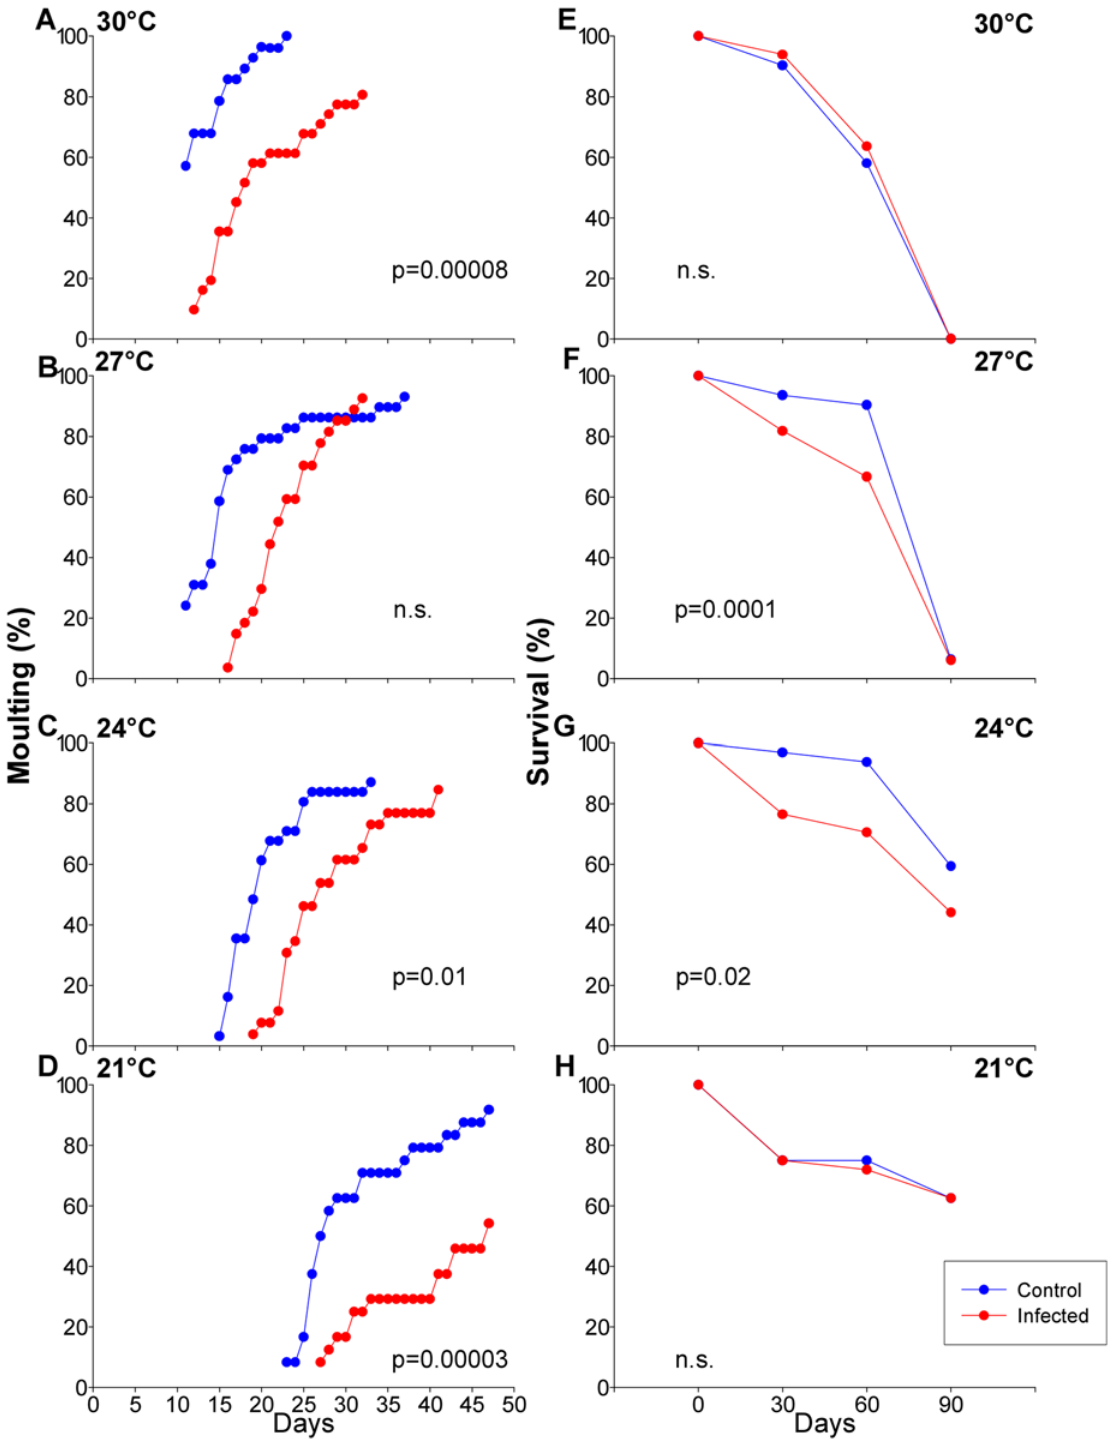
Fig 1. Effects of Trypanosoma cruzi infection on second instar Rhodnius prolixus nymphs over four temperatures. Insects were fed a blood meal at day 0 and were offered no further food. (A-D) time required to moult from second to third instar. (E-H) survival at 30, 60 and 90 days post-blood meal. P values indicated in each graph represent statistical significances of comparisons of infected versus uninfected control insects, using Tukey HSD post hoc tests from nested ANOVA analyses.